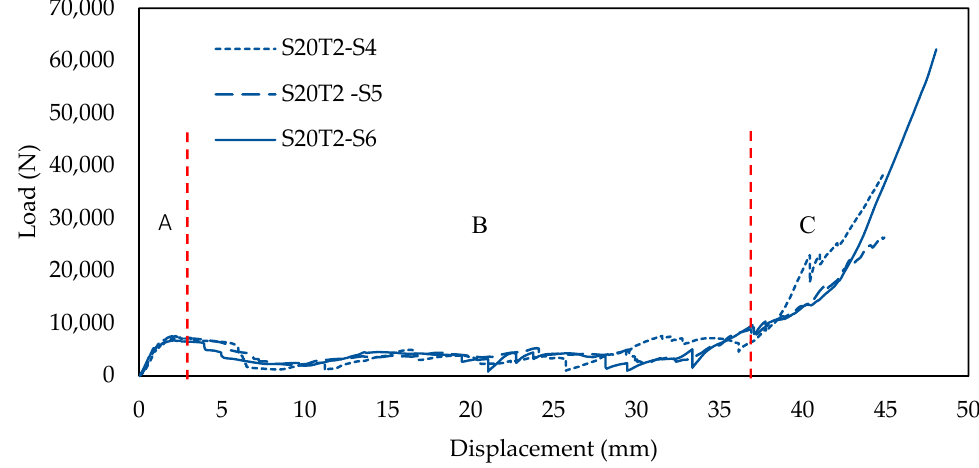
Figure 6. The load-displacement curve for samples with 20 mm cell size with 2 mm wall thickness.